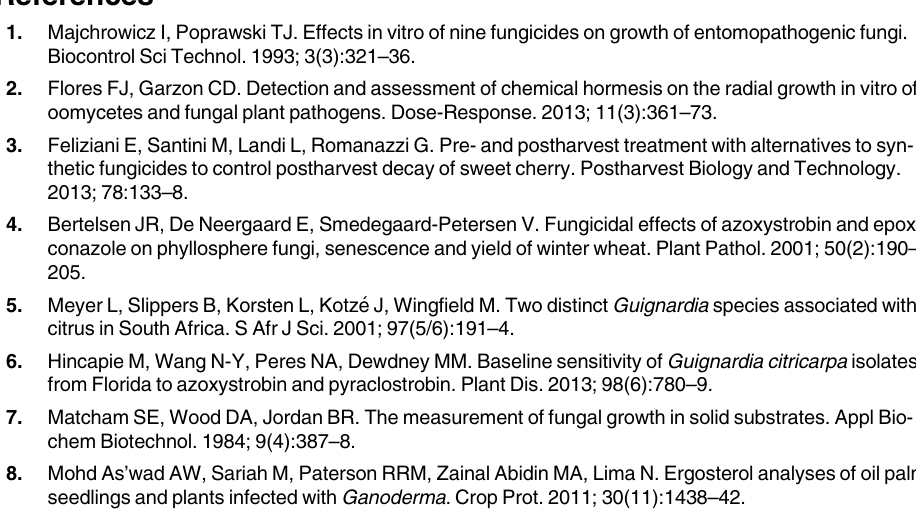
S1 Table. Data set for the in-vitro growth assessment for Phyllosticta citricarpa : Average Colony Diameter vs.